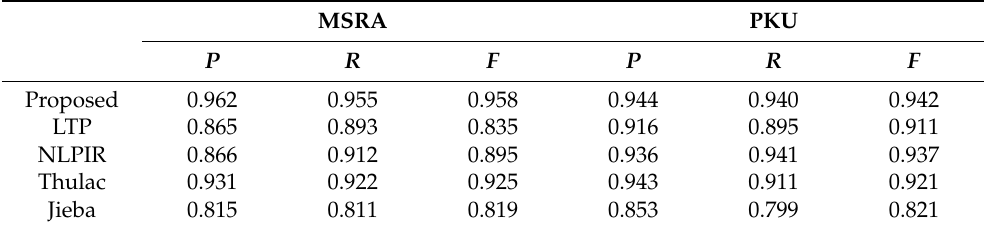
Table 8. Performance comparison of the Chinese word segmentation model.